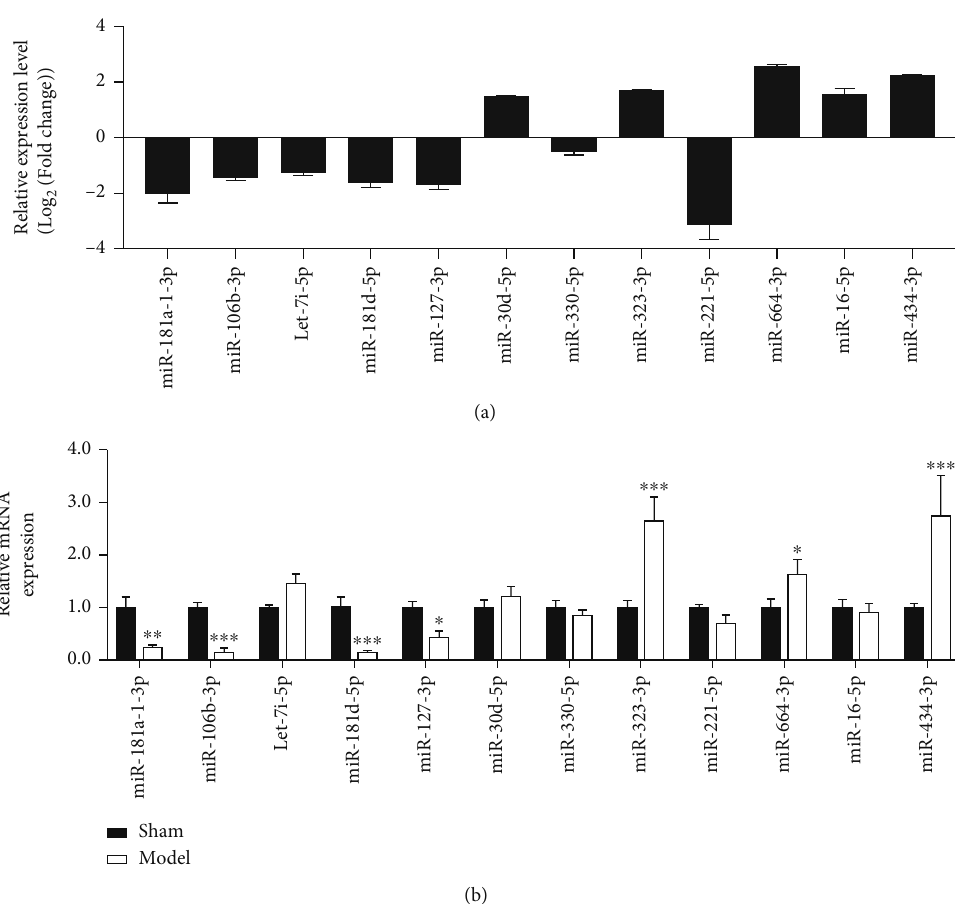
Figure 2: miR-181d-5p is expressed at low levels in injured retinal tissues and RGCs. (a) The RNA-seq data between normal RGCs and injured RGCs (7 days postoptic nerve crush) and selected the top 12 di ff erentially expressed miRNAs. (b) Expression of 12 miRNAs in traumatic retinal tissue by RT-qPCR detection. ∗ P < 0 : 05 , ∗∗ P < 0 : 01 , and ∗∗∗ P < 0 : 001 vs. the sham